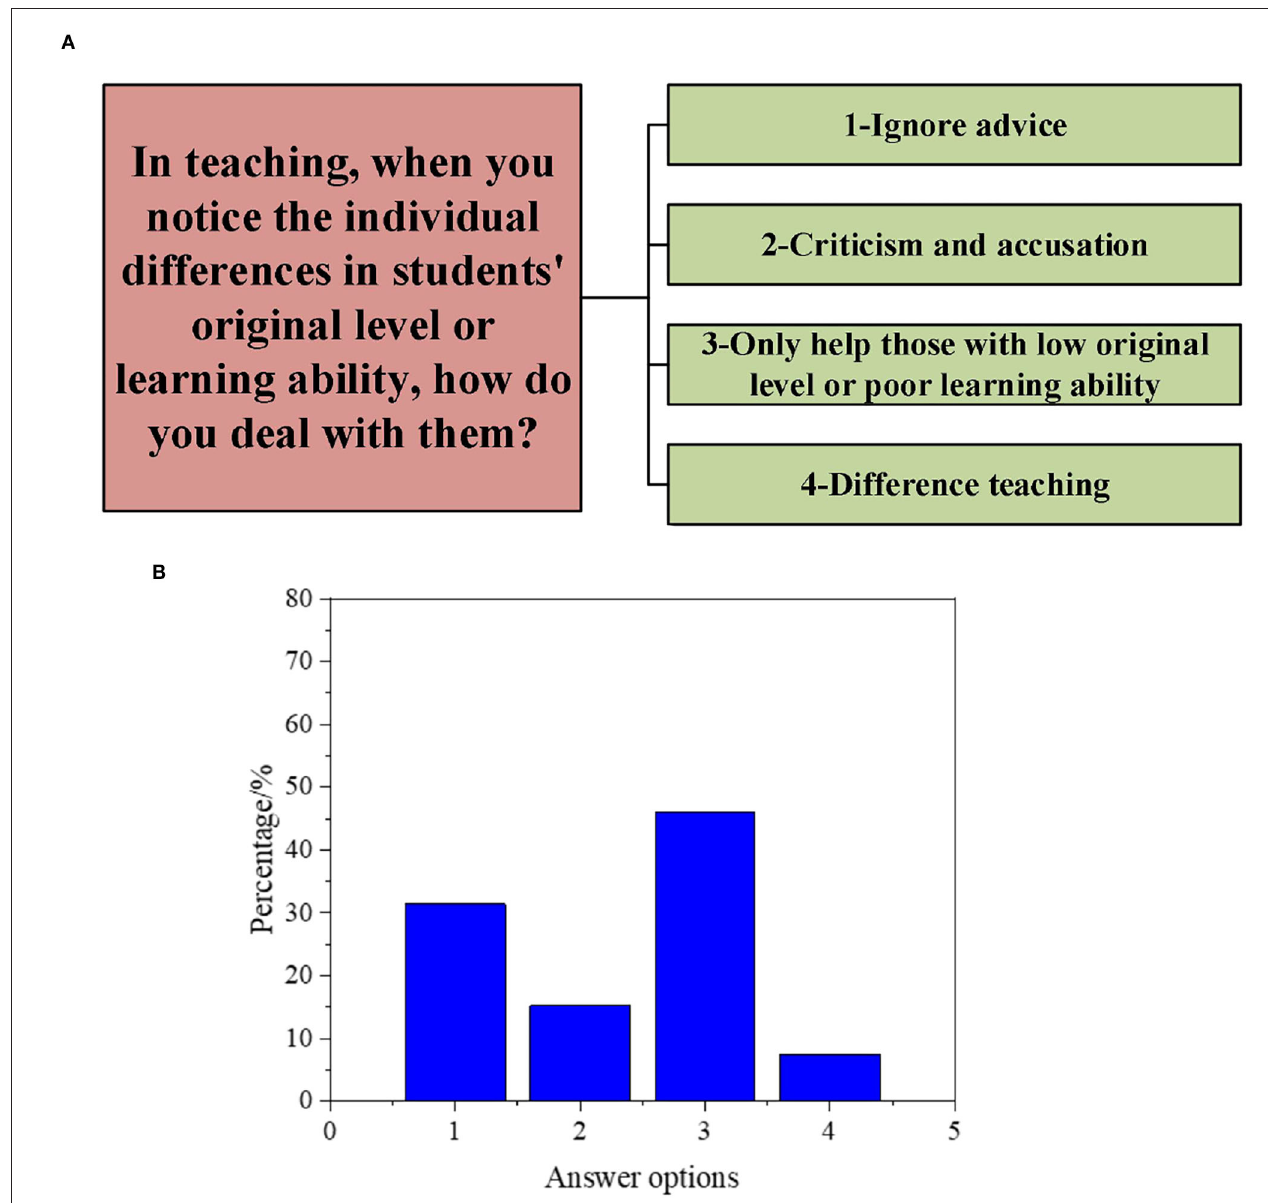
FIGURE 2 | Interview data on students’ individual difference-oriented GCR [ (A) : questions and options; (B) : proportion of